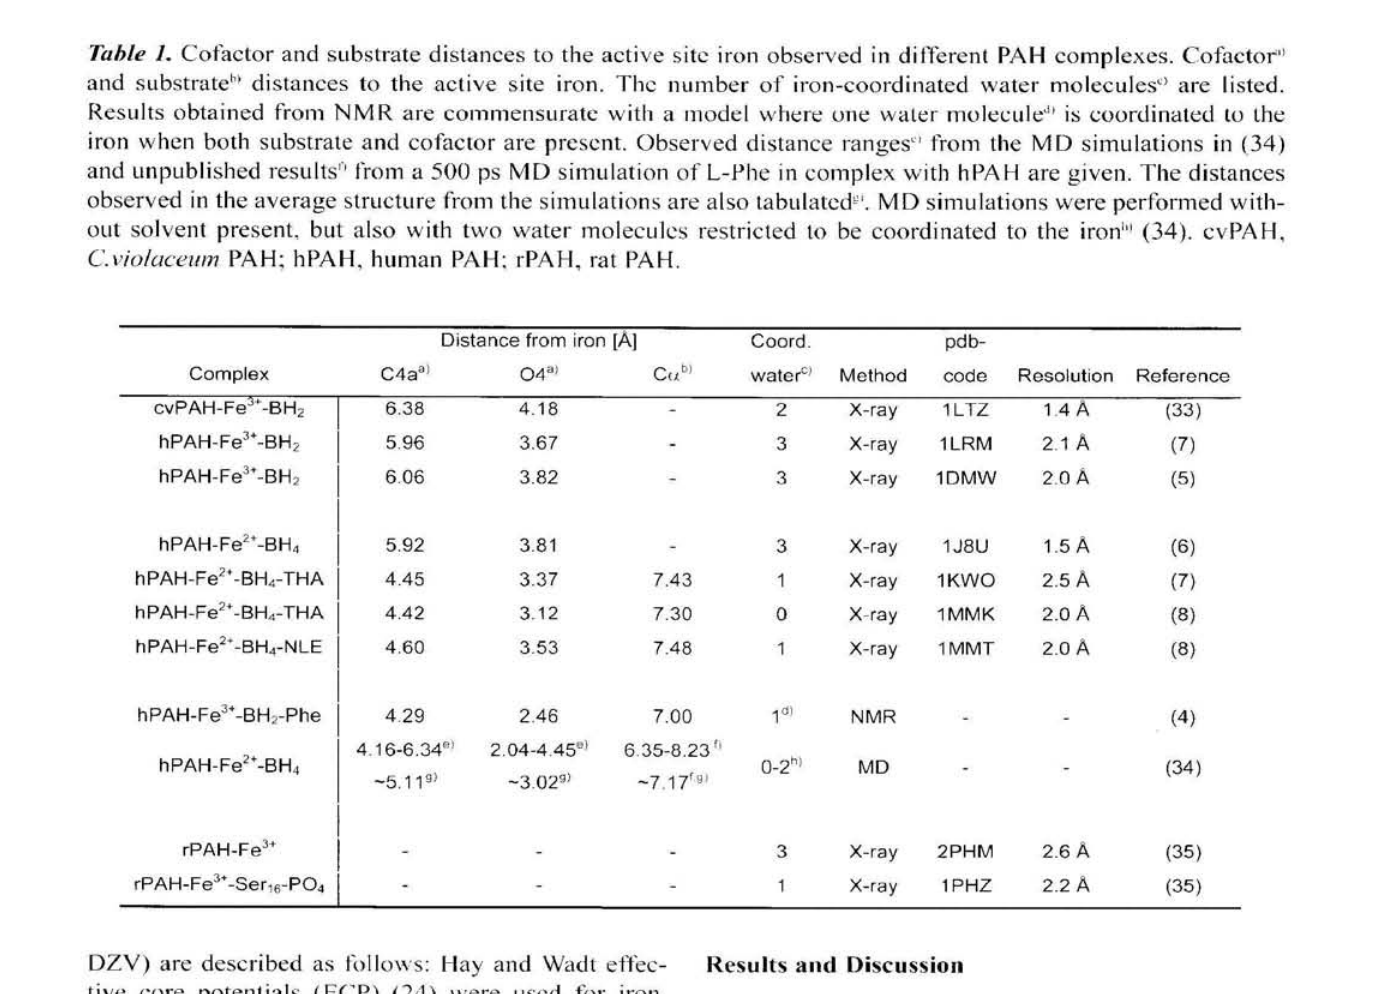
(Fig. 1 ) makes stacking interactions with an invariant